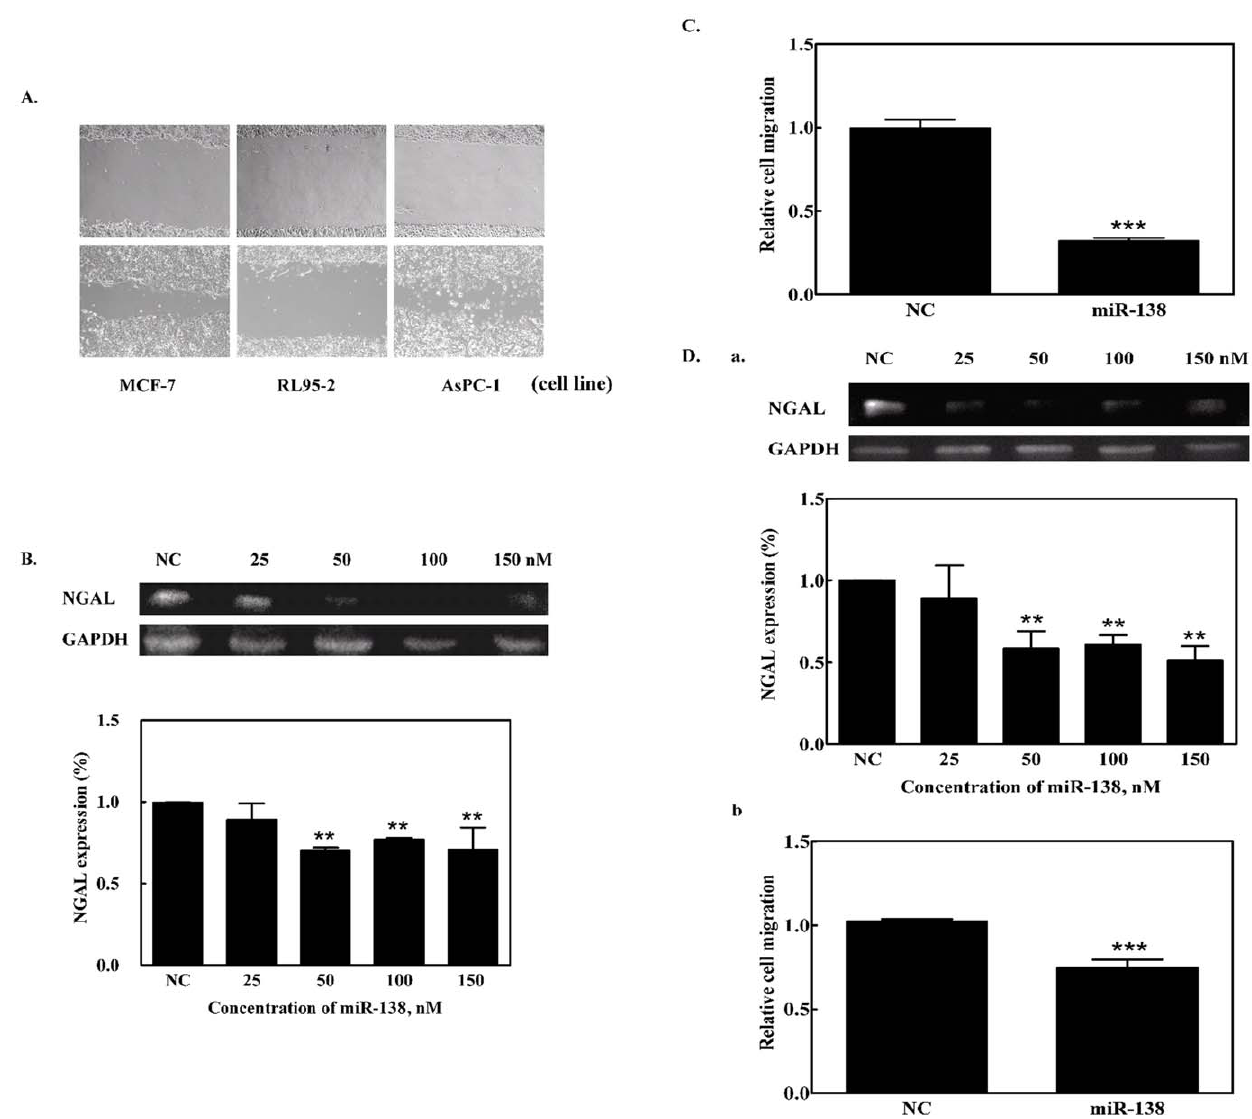
Figure 3. Effect of miR-138 on NGAL expression and cell migration. (A) Images of cell migration of different cell lines. Using the wound- healing assay for the three cancer cell lines, wounds were compared at 0 and 24 h after scratching. Light microscope image at 100 6 magnifications. (B) Western blot for NGAL expression in miR-138-transfected AsPC-1 cells. (C) For the transwell cell migration assay, cells that had migrated after a specified period were quantified using crystal violet staining. (D) The effect of miR-138 on (a) NGAL expression as determined by western blot analysis, and (b) cell migration for RL95-2 cells. ** indicates p , 0.01, *** indicates p , 0.001. NC: negative control, precursor miRNA.